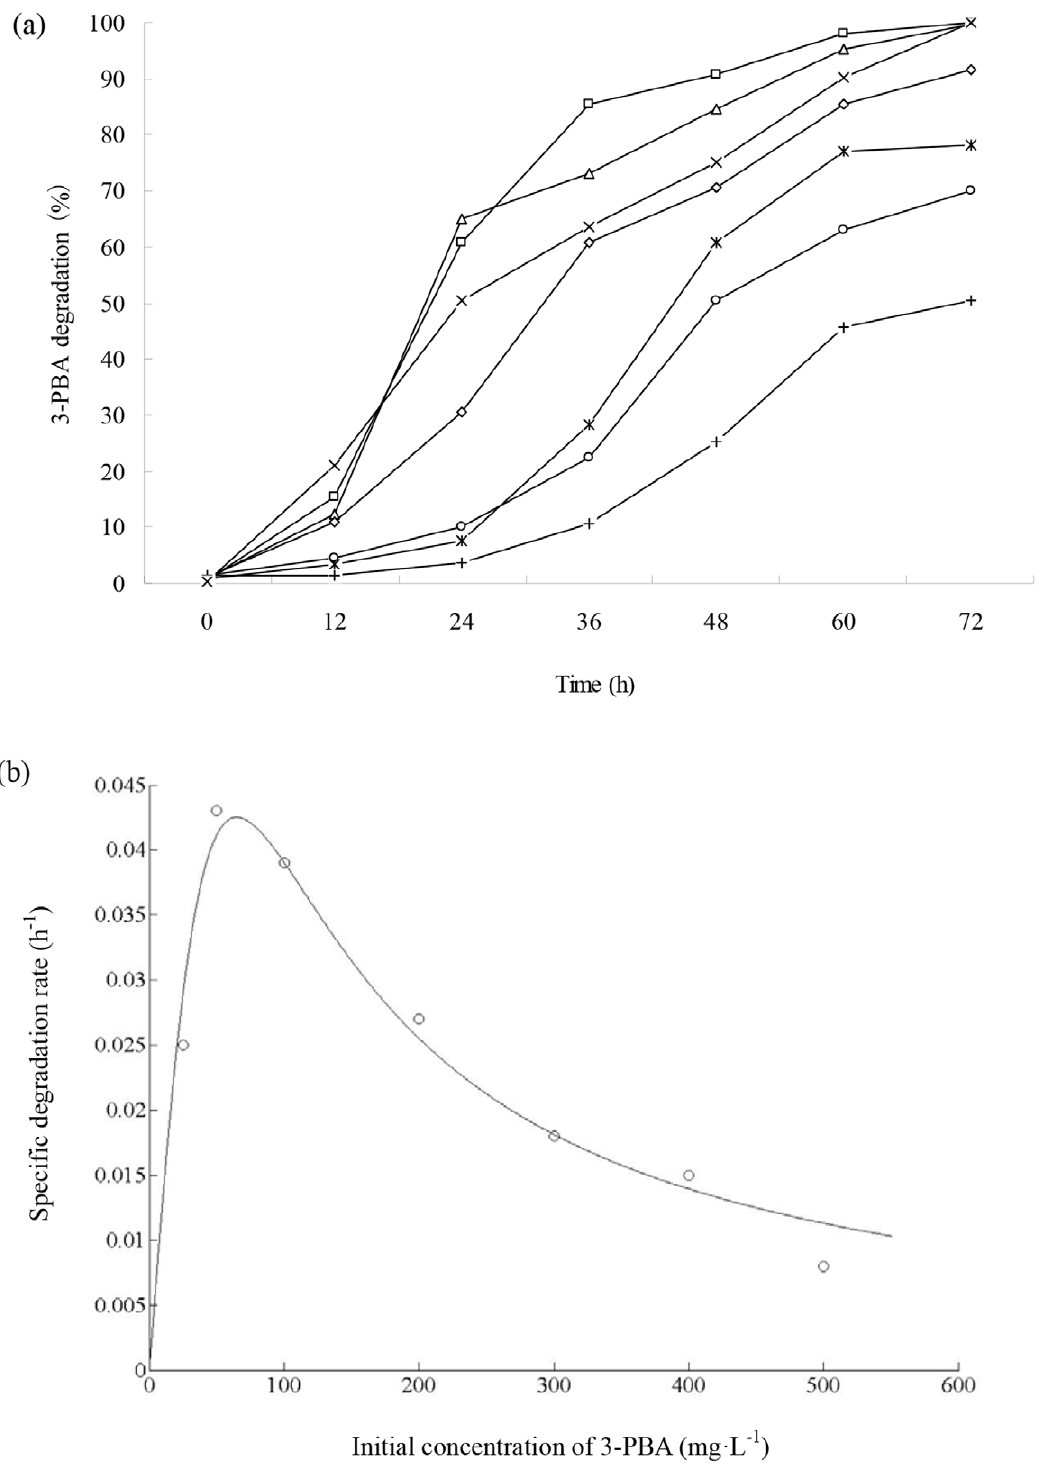
Figure 4. (a) Degradation of 3-PBA with different initial concentrations by strain DG-02. g , 25 mg ? L 2 1 ; % , 50 mg ? L 2 1 ; 6 , 100 mg ? L 2 1 ; e , 200 mg ? L 2 1 ; *, 300 mg ? L 2 1 ; # , 400 mg ? L 2 1 ; + , 500 mg ? L 2 1 . (b) Relationship between specific degradation rate and initial 3-PBA concentration. respectively. In contrast, the t 1/2 for 3-PBA in the non-inoculated soil treatments were 101.9 and 187.3 days, respectively. These results demonstrated that inoculation with strain DG-02 resulted